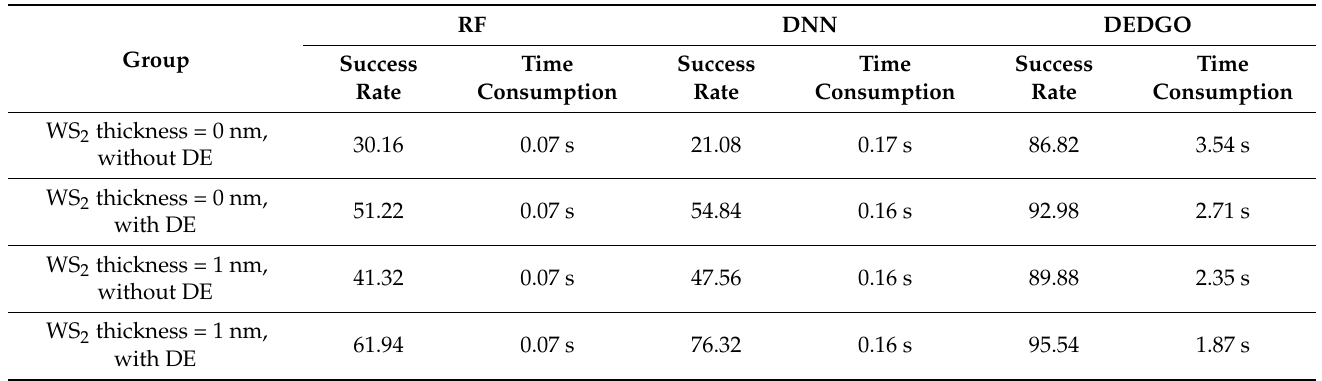
Table 1. The average success rate and time consumption of different